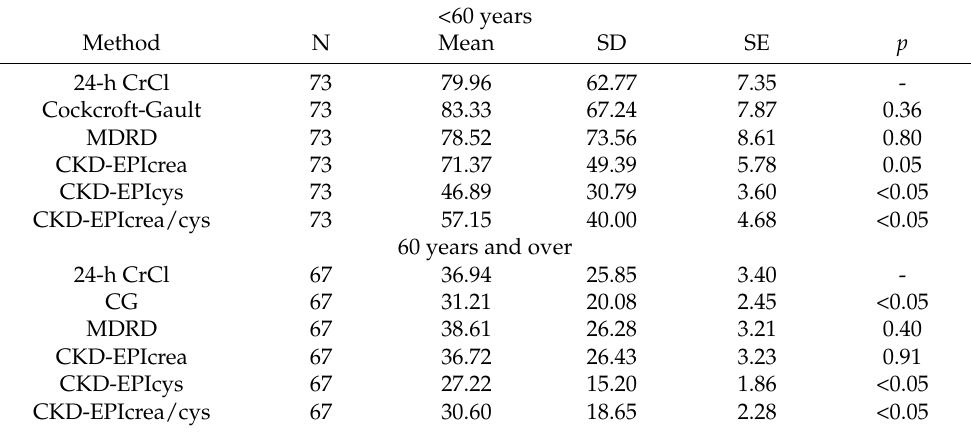
Table 5. Comparison of methods (mL/min) in patients <60 years of age vs. patients 60 years and over. <60